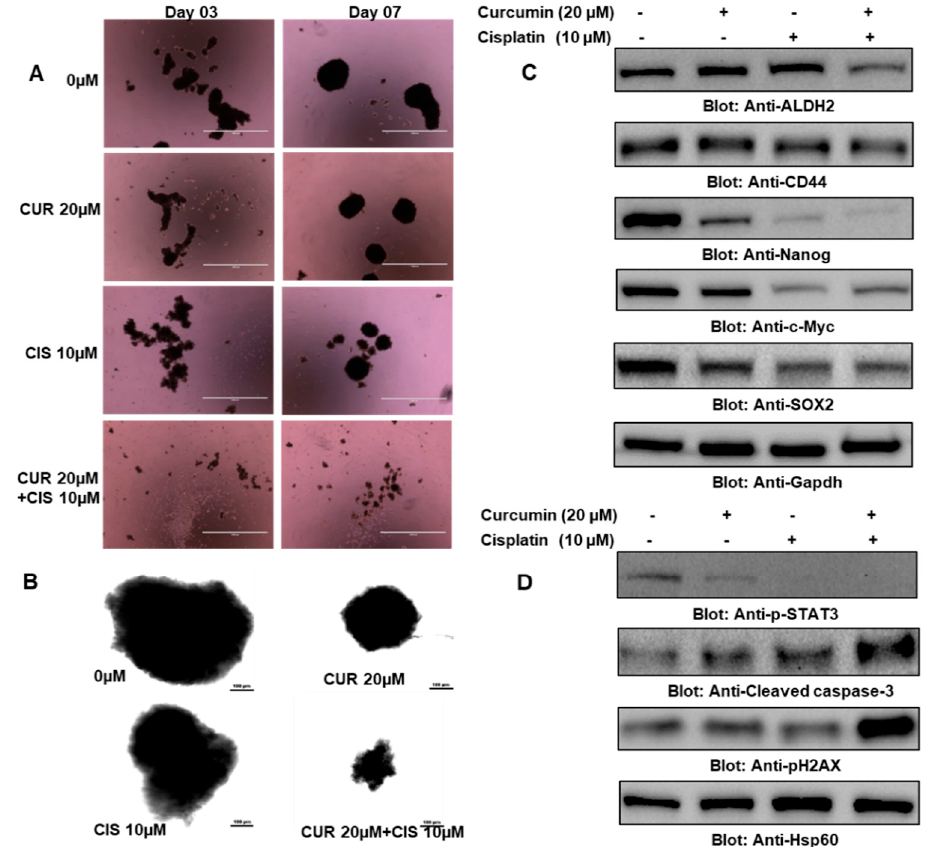
Figure 9. Cotreatment of curcumin and cisplatin potentiated the inhibition of cancer stem cell (CSC) growth and stemness features. ( A ) Treatment with curcumin and cisplatin inhibited thyrosphere formation. BCPAP cells were grown and treated in ultralow attachment plates with 0 µ M or 20 µ M of curcumin and 10 µ M of cisplatin alone and in combination for 7 days, and images of thyrospheres were taken on day 3 and day 7 using an EVOS FLc Cell Imaging System from Invitrogen (Thermo Fisher Scientific) at a magnification of 4 × (scale bar 1000 µ m). ( B ) BCPAP cells were grown and treated